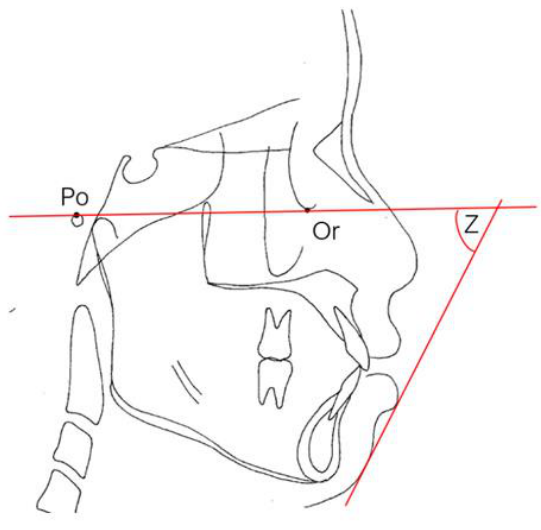
Figure 8. Z angle. The angle formed by the intersection of the Frankfort horizontal plane and a line connecting the soft tissue pogonion and the most protrusive lip.